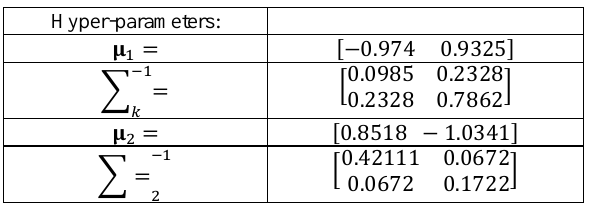
Figure 3. DEN trained to solve a straightforward example. Blue ellipsoid encloses patterns belonging to first class; green ellipsoid does the same but patterns from second class. Table 1. Hyper-parameters of the trained DEN to solve the provided straightforward example.